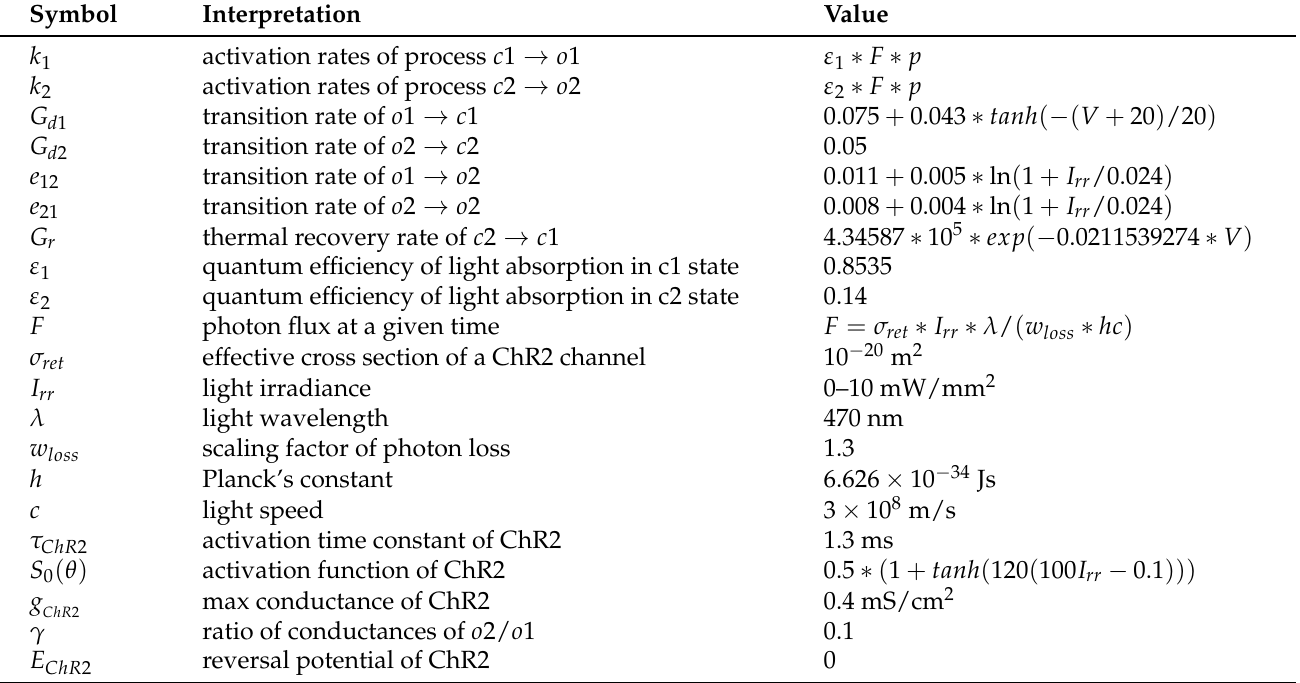
Table 1. Brief descriptions and baseline values of optogenetic stimulation model